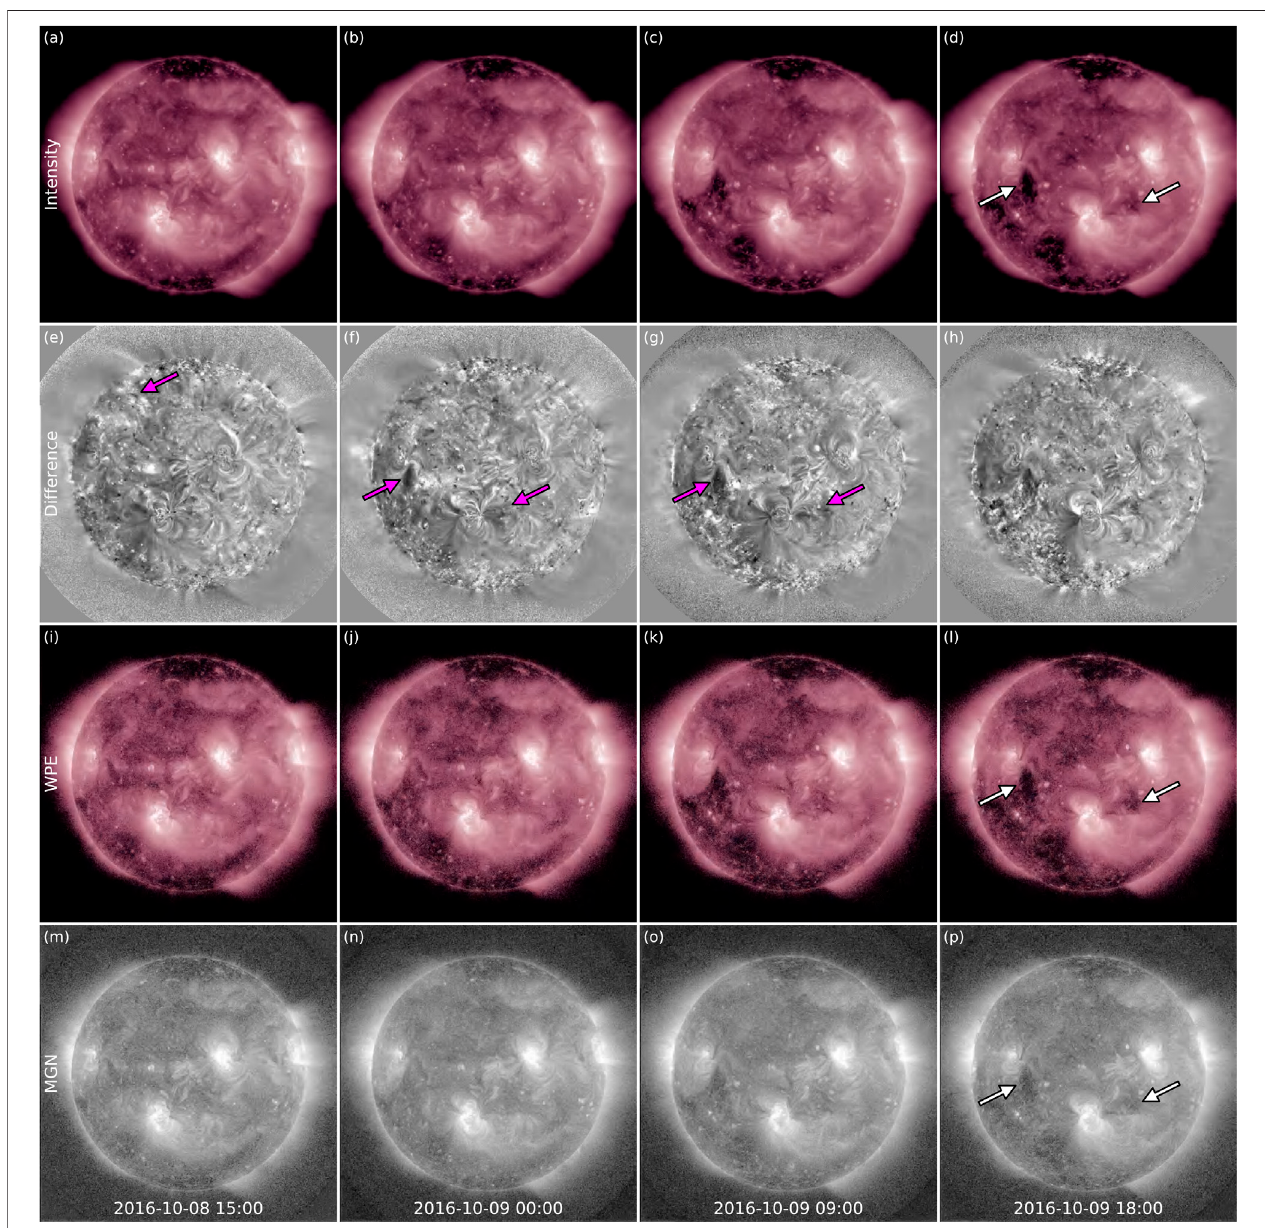
FIGURE 7 | Imaging techniques applied to the 2016 October 8 CME (Event 4). SDO/AIA 211Å images are shown at four different times and processed with four different methods. (A – D) Intensity images. (E – H) Difference images with fi xed Δ t (cid:2) 12 h. (I – L) WPE-processed images. (M – P) MGN-processed images. Dimming and brightening regions are indicated with arrows (see text for